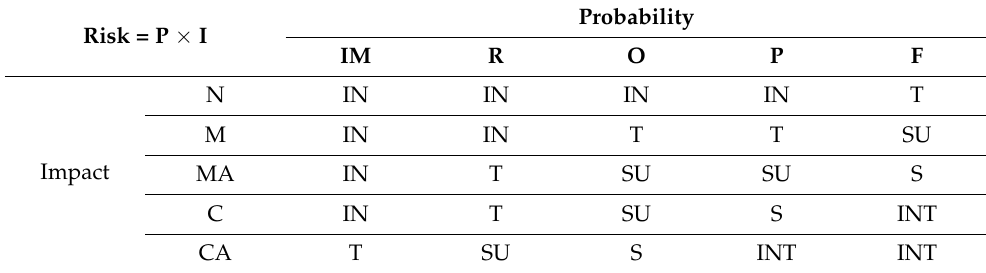
Table 3. Risk Matrix.